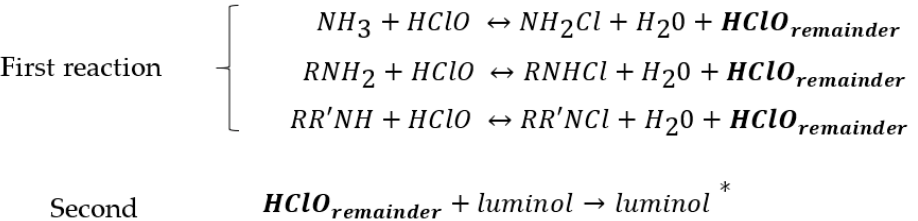
Figure 1. Reactions involved in the chemiluminescence assay. Luminol* is the excited electronic state of the oxidized form and sheds its “extra” energy by emitting a photon of light.